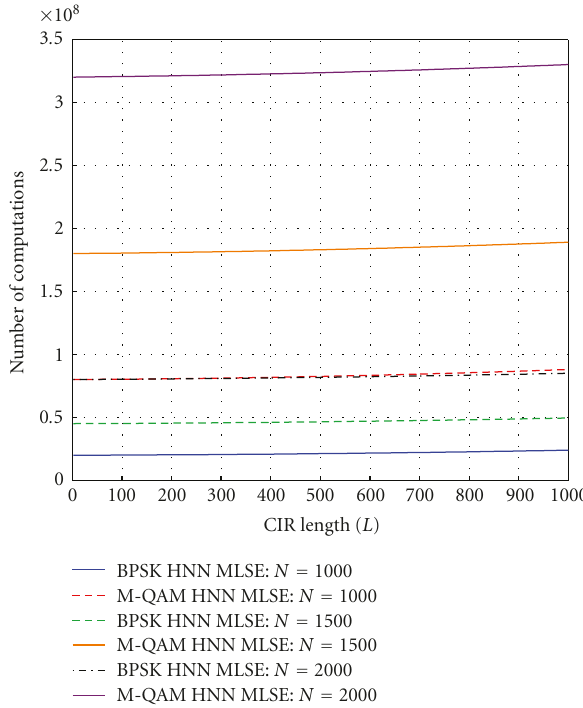
Figure 12: Computational complexity comparison for the HNN MLSE equalizers for realistic data block